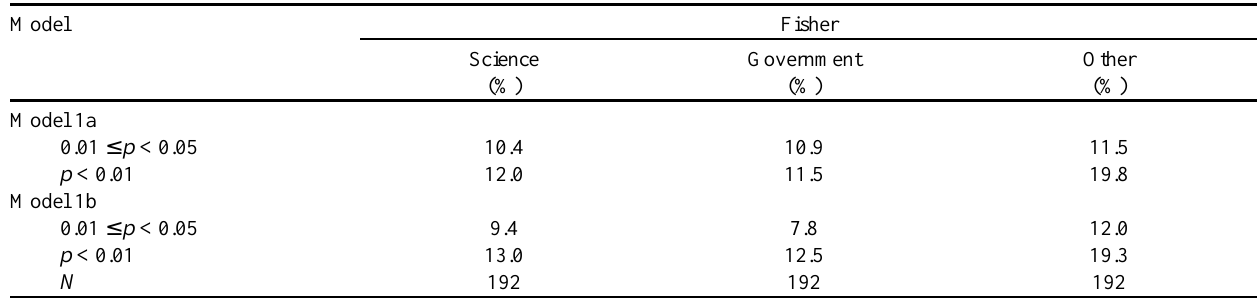
Table 3 . Statements with significant differences among stakeholder